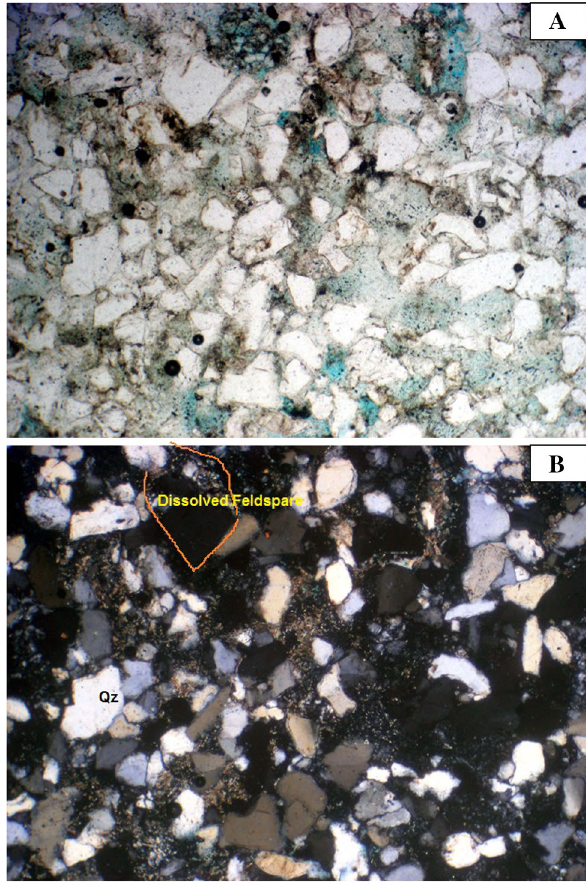
Fig. 11 Photomicrographs showing the quartz arenite microfacies with dissolved feldspar, concave–convex contacts, iron oxide and intergranular porosity